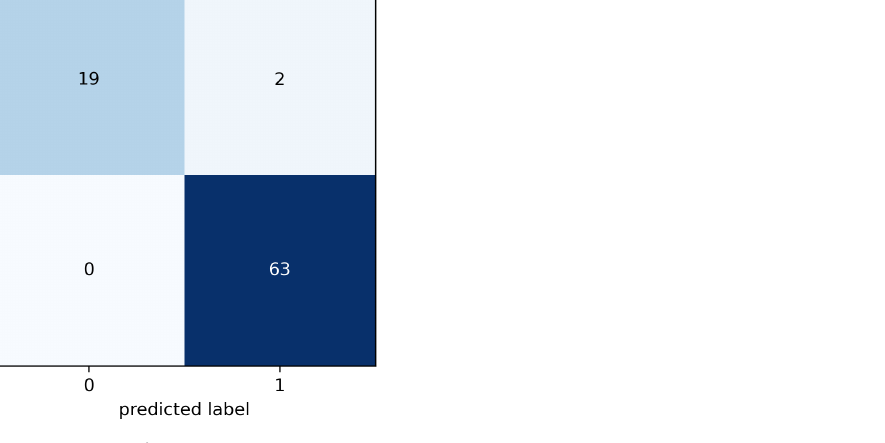
Figure 13. SVM confusion matrix.